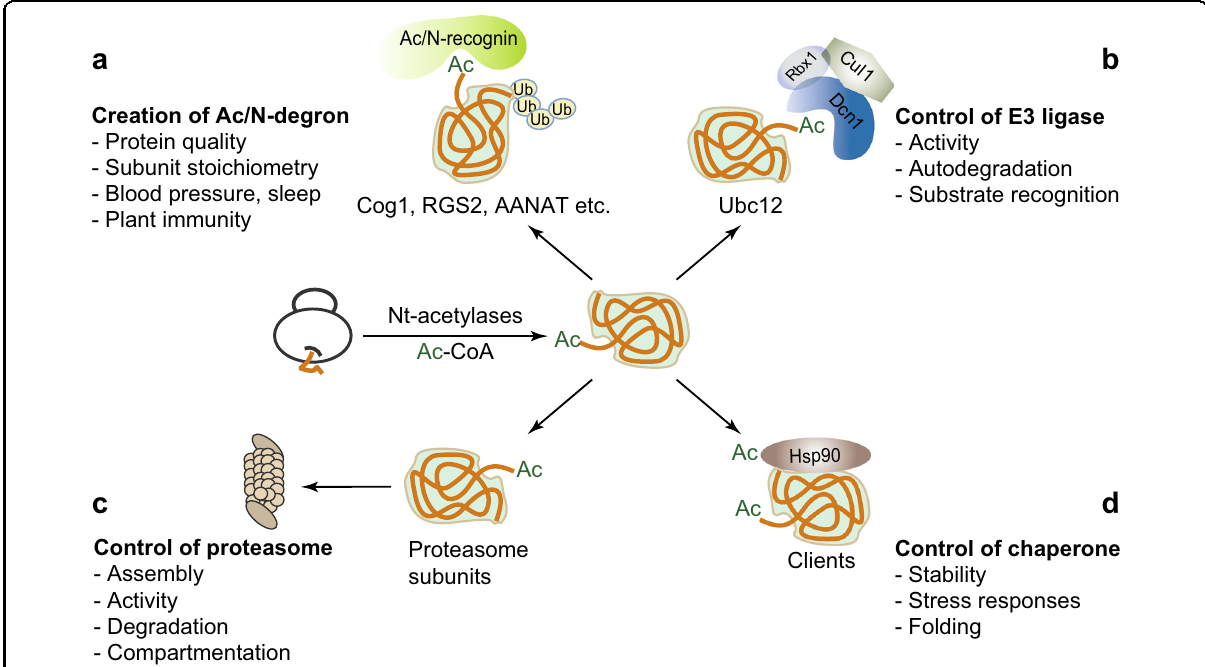
Fig. 2 Control of protein degradation by Nt-acetylation. a N-terminally acetylated proteins can be targeted for degradation by the Ac/N-end rule pathway. b Nt-acetylation controls the activity or degradation of E3 ligases. c Nt-acetylation contributes to the activity, assembly, degradation, and compartmentation of 26S proteasomes. d Nt-acetylation protects Hsp90 and its clients from degradation. Unacetylated Hsp90 and its unacetylated clients are targeted for degradation by the Arg/N-end rule